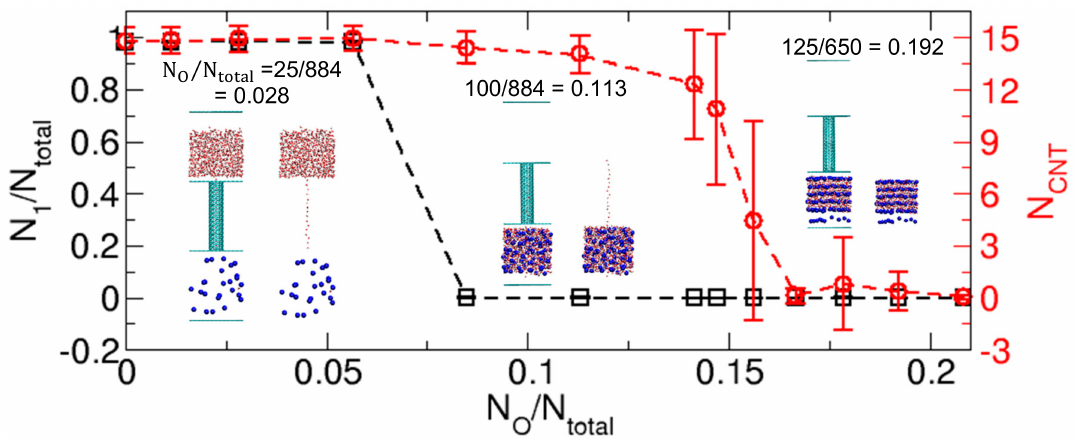
Figure 7. Kinetically stable states observed for a range of N O / N total , the ratio of the number of osmolytes ( N O ) to the total number of water molecules ( N total ). The stable states are characterized by the occupancy ratio of water molecules in Compartment 1 ( N 1 / N total ) and the number of water molecules in the CNT ( N CNT ), averaged over the time interval from 100 ns to 200 ns in the 200 ns simulations. The insets illustrate three representative configurations of States I, II, and III, whose values of N O / N total are 0.028, 0.113, and 0.192, respectively, which are taken at 200 ns from the 200 ns simulations. The error bars indicate the standard